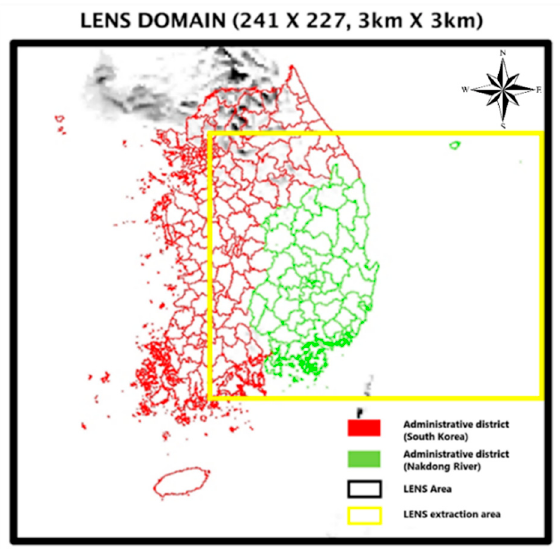
Figure 3. LENS domain.